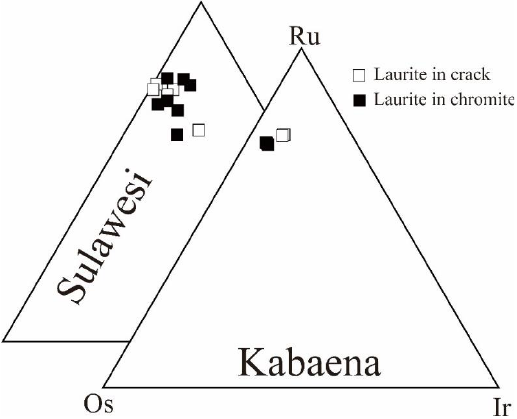
Figure 11. BSE images of secondary Ir-Os alloy from Kabaena Island chromitite ( A ) and enlargement of A ( B ). Abbreviations: chr = chromite, srp = serpentine, olv = olivine, Ir-Os = iridium–osmium alloy, and awr = awaruite.